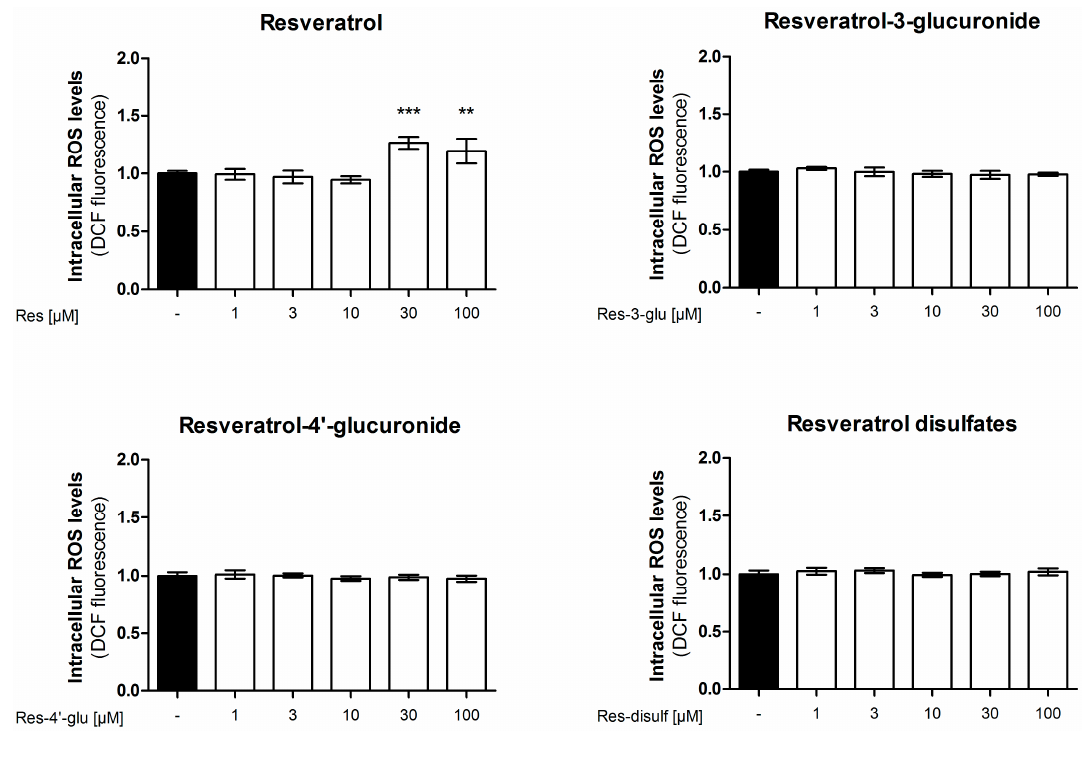
Figure 5. Influence of resveratrol and its metabolites on intracellular reactive oxygen species levels. EA.hy926 cells were treated with the indicated concentrations of resveratrol or its metabolites for 24 h. Intracellular ROS was measured by incubation with the